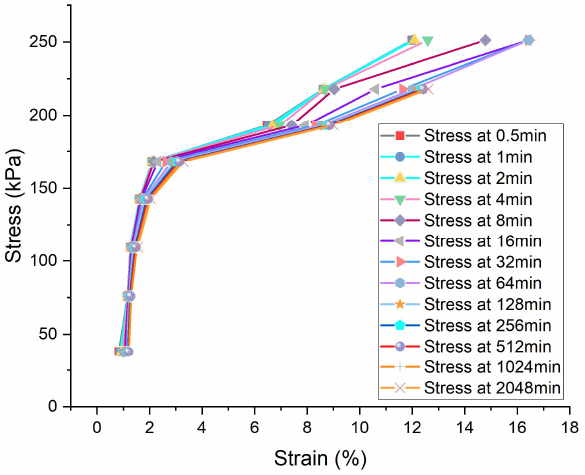
) - (𝜀 ) curves of Specimen No. 24, 7 FTHs. (cid:2869) − 𝜎 (cid:2871) (cid:2869)